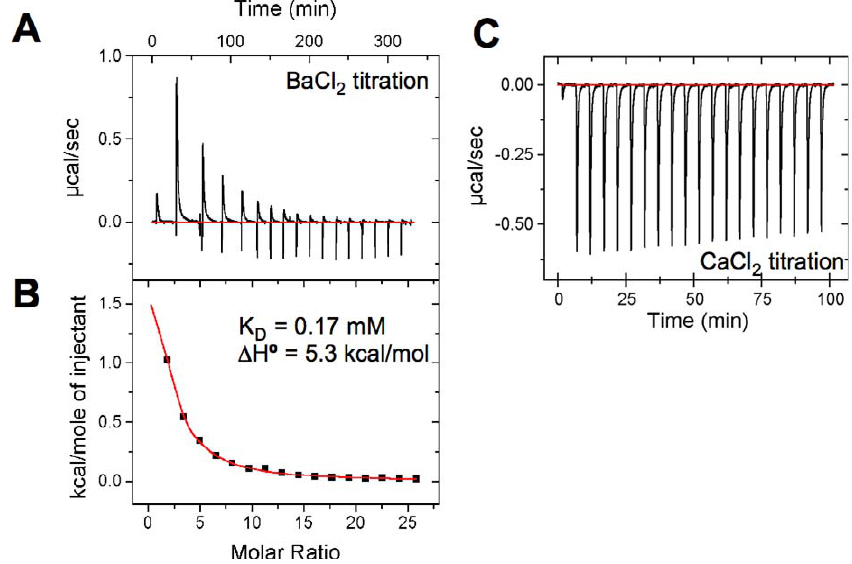
Figure 5. ITC Titration of Alkaline Earth Metal Cations Binding to KcsA (A) A BaCl 2 solution is titrated into a solution containing KcsA. (B) The total heat exchanged is fit to a single binding isotherm with K D and D H 8 as independent variables. (C) A CaCl 2 solution titrated into a solution containing KcsA shows no ion binding.